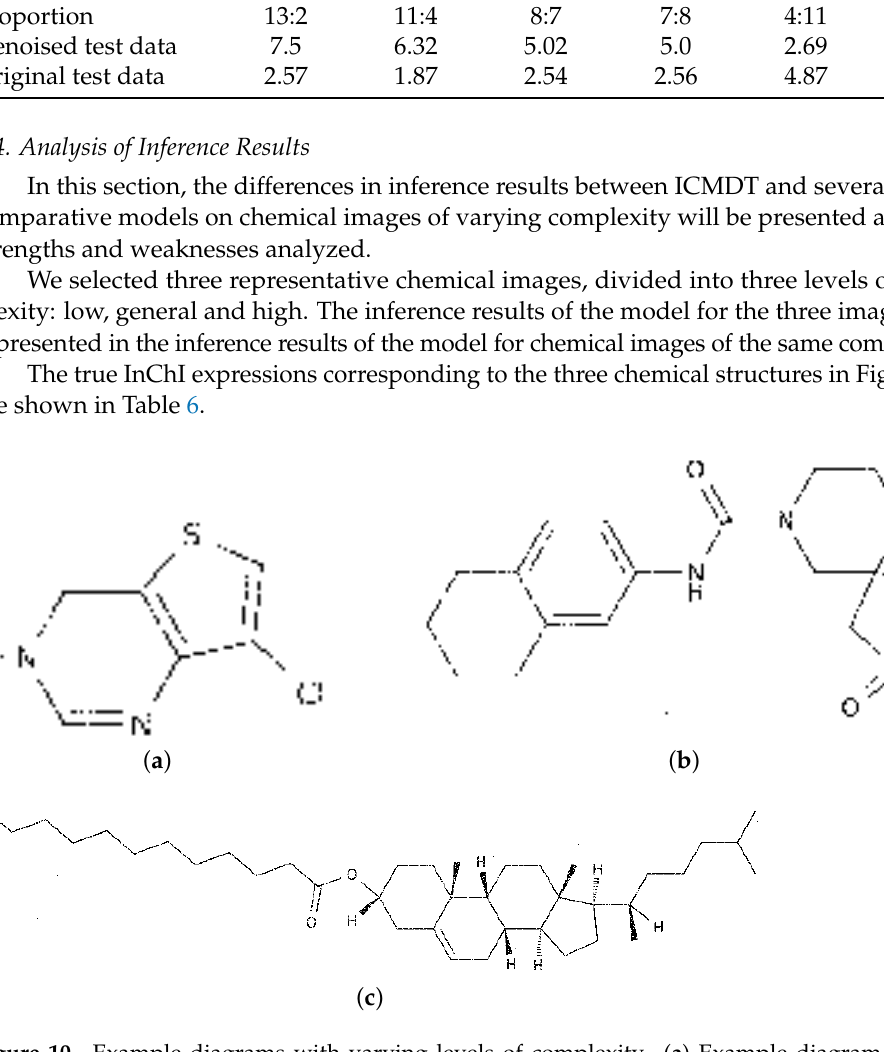
Figure 10. Example diagrams with varying levels of complexity. ( a ) Example diagram of low complexity. ( b ) Example diagram of general complexity. ( c ) Example diagram of a high level of